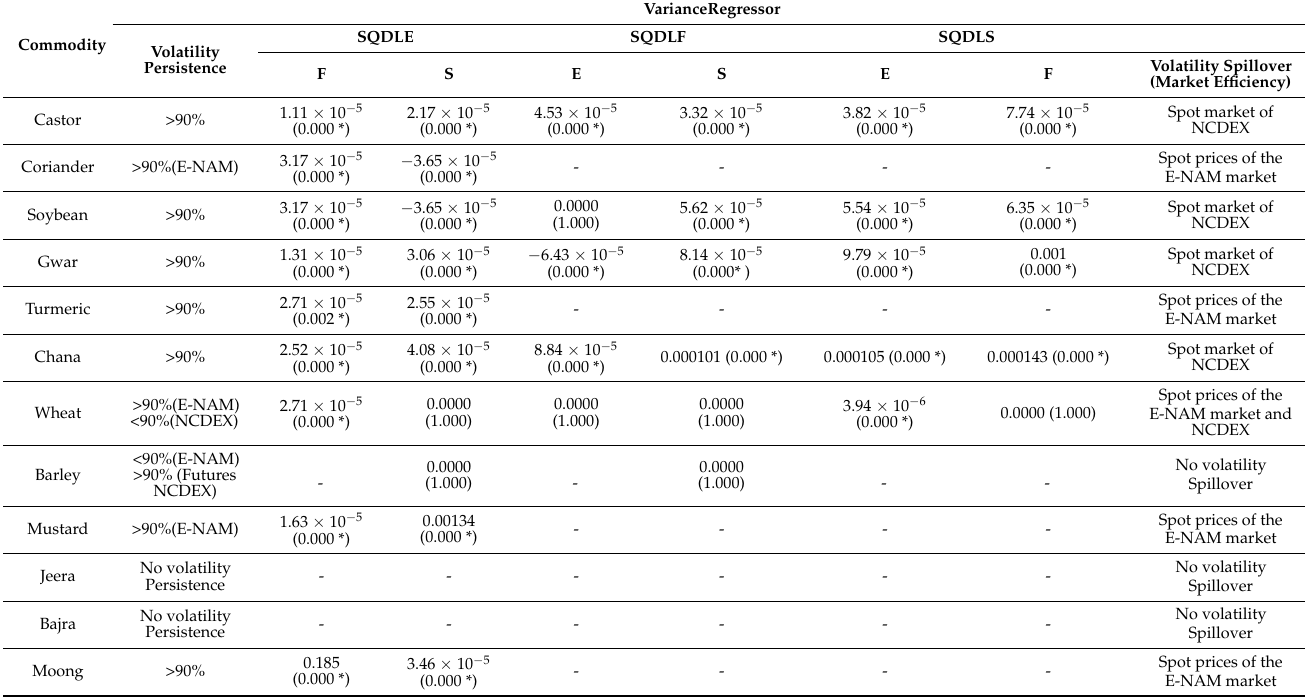
Table 5. Results of Volatility Spillover